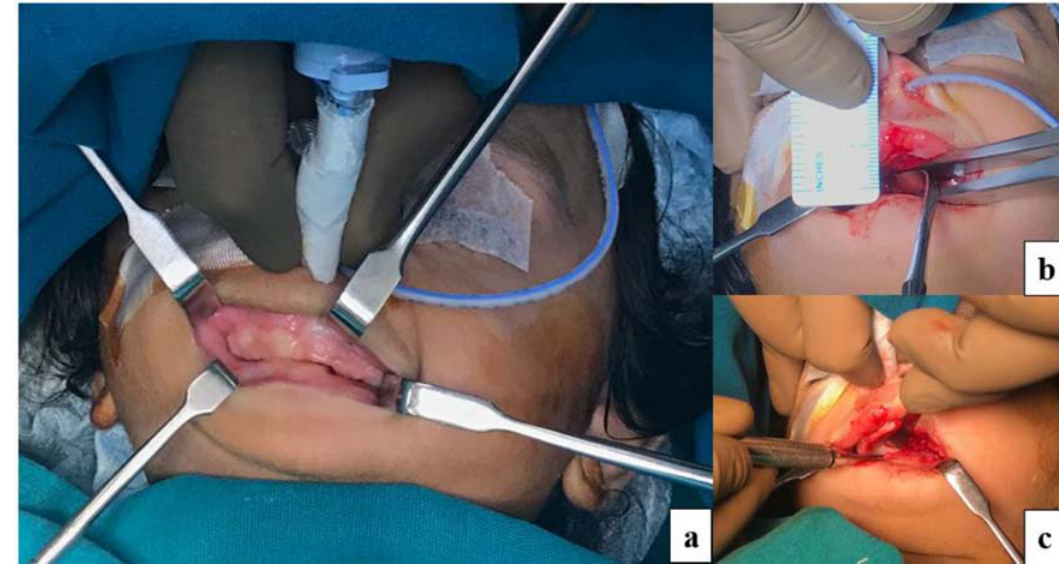
Fig. 3. Intraoperative release of syngnathia and synechiae.